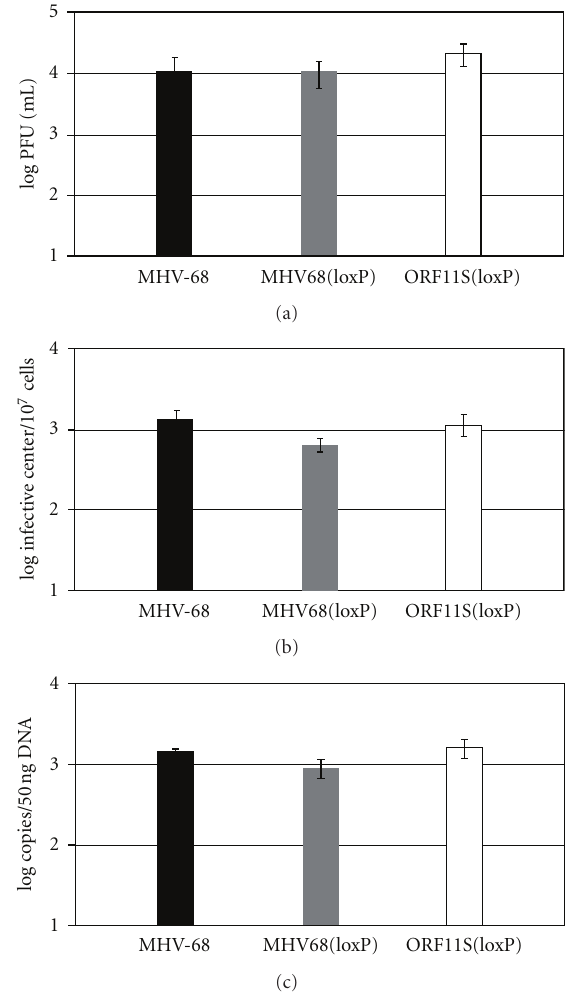
Figure 6: ORF11 is not required for viral infection in Balb/c mice. (a) The acute lung viral titers. Balb/c mice were intranasally inoculated with 20PFU of each virus. The lungs were harvested at day 9 after infection and the titers were determined by plaque assays. Shown are the means of viral titers from 3 mice per virus infection and the standard errors of the means. (b) The viral latency in spleens. 20 PFU of each virus was inoculated into Balb/c mice. The spleens were harvested at day 15 after infection and the amounts of latent virus were determined by infective center assays. (c) The copy numbers of viral genomes in the spleens harvested at day 15 after infection. 50ng of splenic DNA was used for real-time PCR to determine the viral DNA copy numbers. Shown are the means from 3 mice per virus infection and the standard errors of the